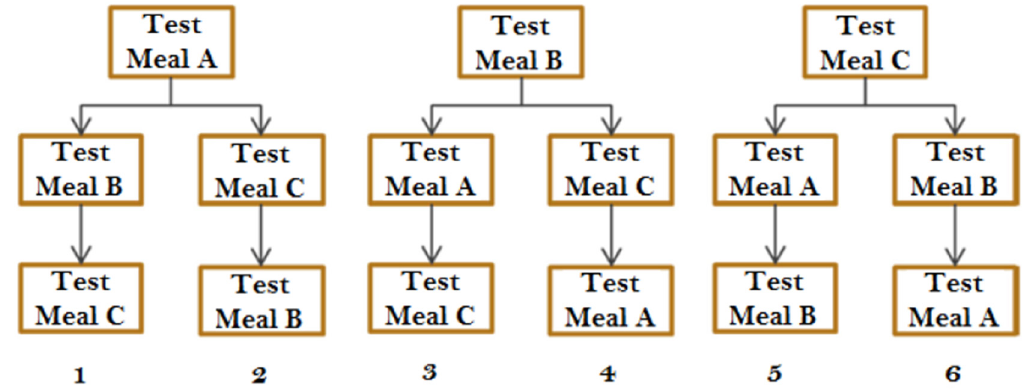
Figure 1. Scheme of breakfast meal sequences for each treatment pattern during the clinical trial phase. Meal A: control, no added protein; Test meal B: added WPI, Test meal C: added SPI. Six final test meal sequences were possible.